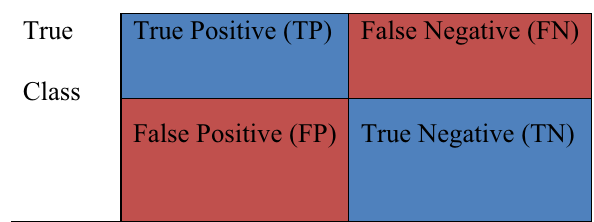
Figure 1. Confusion matrix and its data.